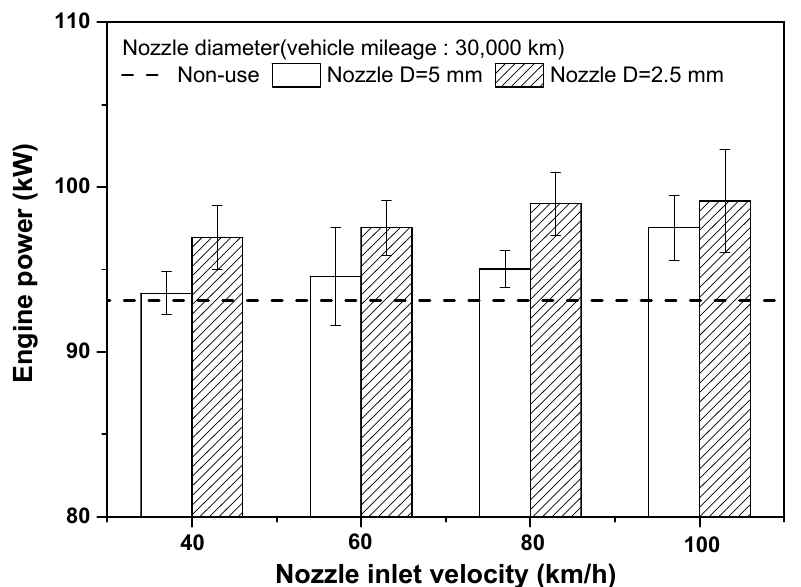
Figure 6. Comparison of the engine power according to nozzle diameter for the 30,000 km mileage engine.